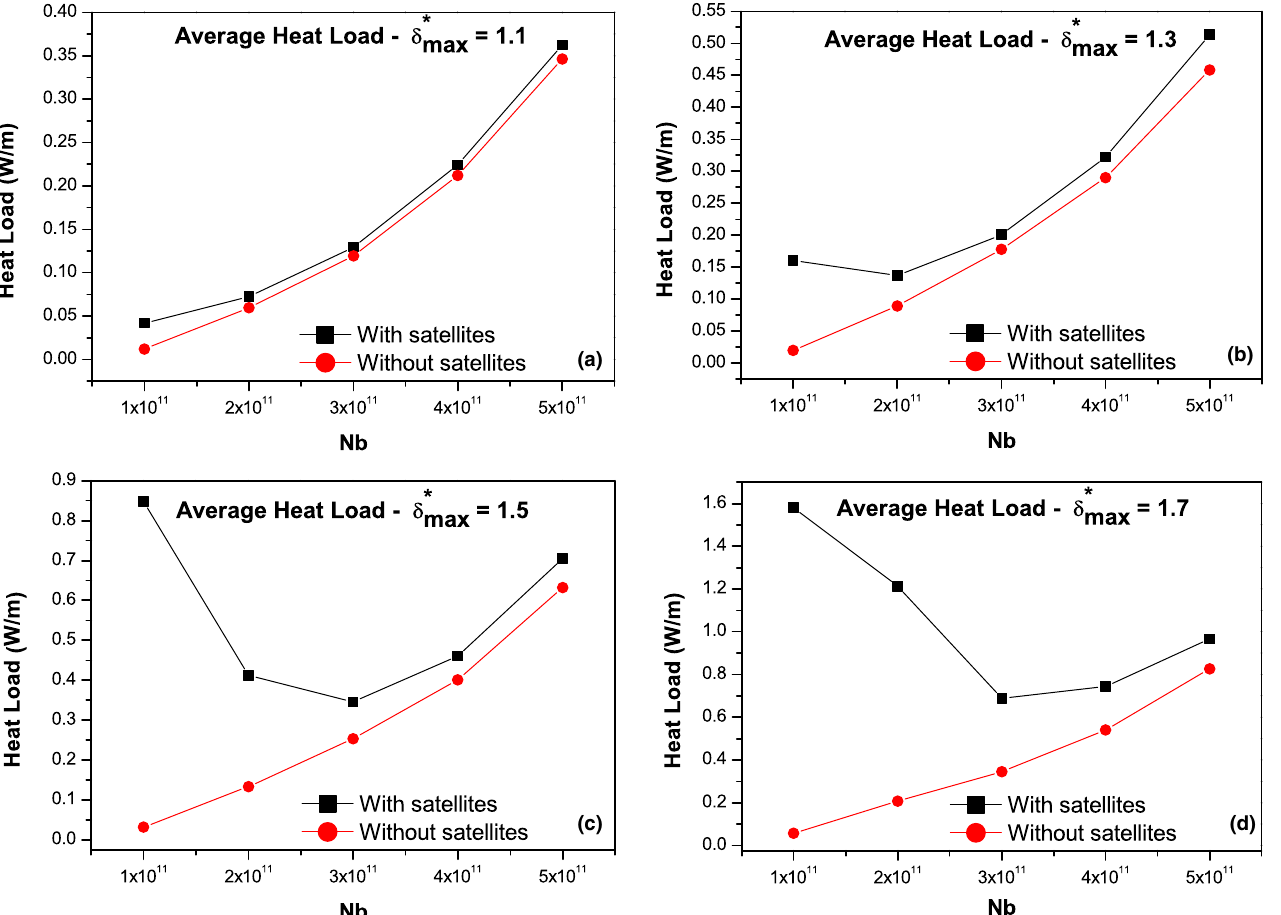
FIG. 13. Comparison of average heat load for satellite bunches (black line) and the nominal scenario without satellite (red line) for a (cid:1) (cid:3)